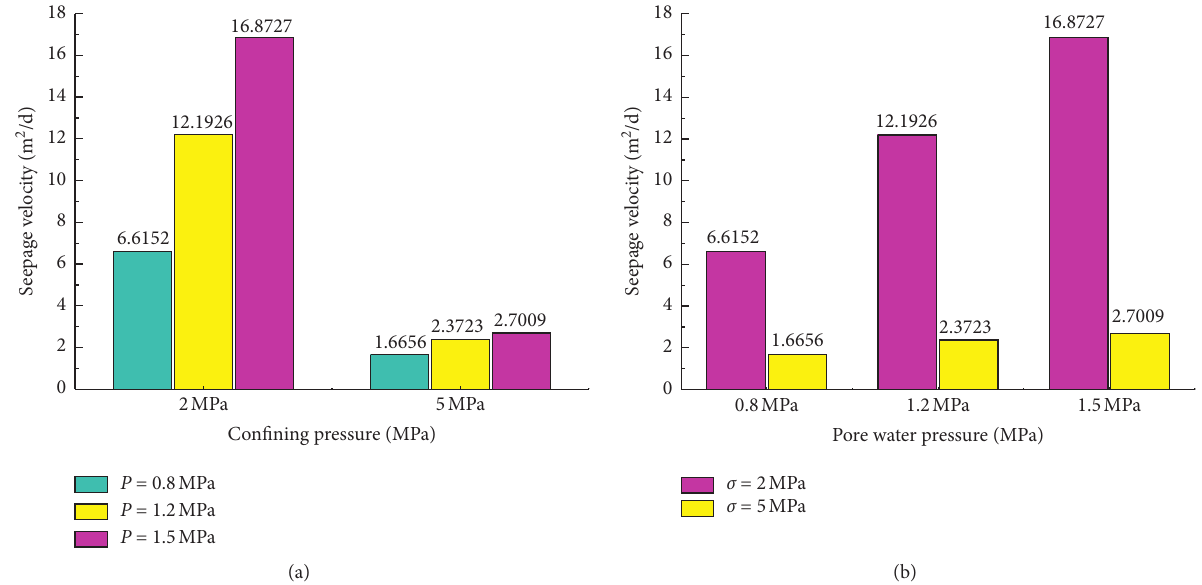
Figure 7: Effects of different factors on axial seepage velocity of cracked specimens: (a) cases with constant confining pressure; (b) cases with constant water